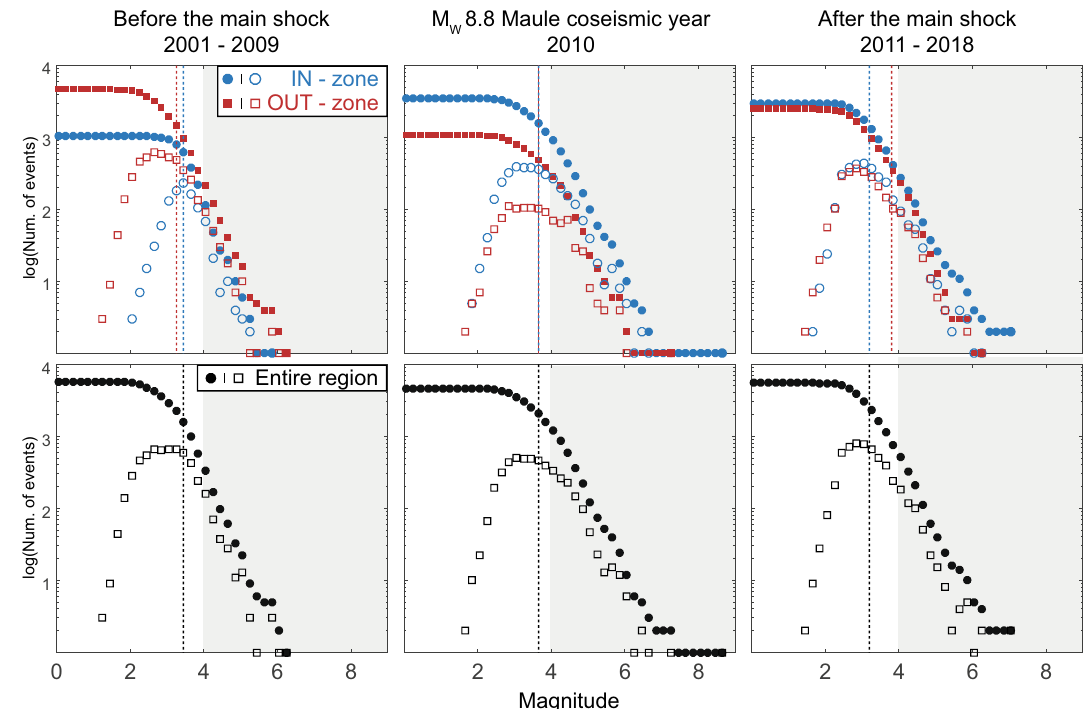
Figure 2. FMD variations of the ISC catalogue for the studied areas from 2000 to 2018. Cumulative FMD for the IN-zone dataset (filled blue circles), OUT-zone (filled red squares), and the entire region defined in Fig. 1 (filled black circles). The non-cumulative FMD are represented with the same color-code but with empty symbols (blue circles, red squares and black squares for the IN, OUT and entire region, respectively). Vertical dashed lines indicate the highest value of the magnitude of completeness M C computed for each dataset using MAXC and MBS methods (see Methods section). The grey zones represent the magnitude range of the data used in this study (M > 4), which is larger than the local magnitude of completeness of the